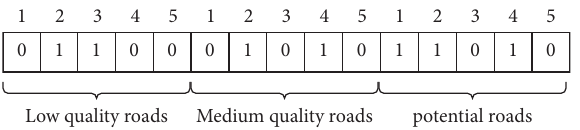
Figure 1: A solution representation of X